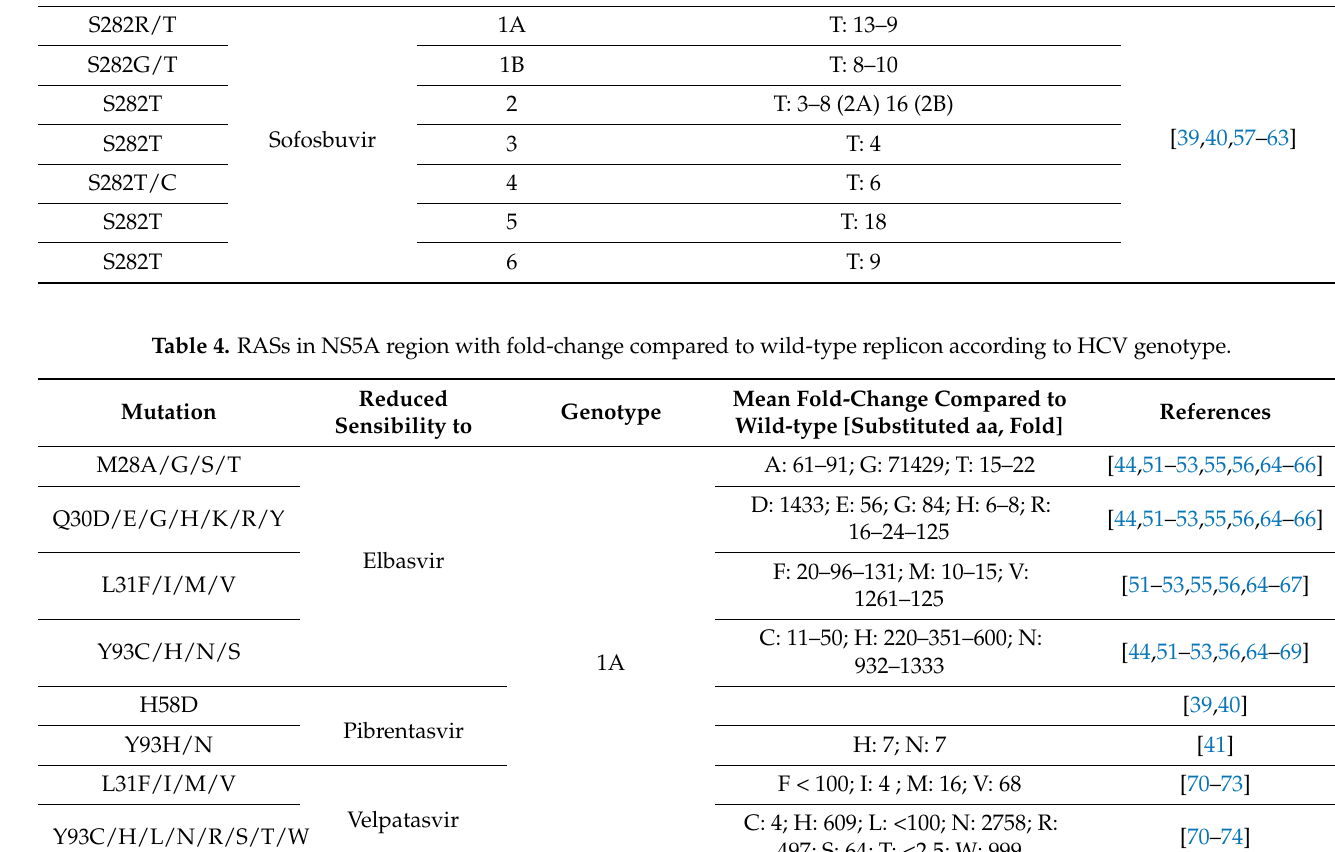
Table 3. RASs in NS5B region with fold-change compared to wild-type replicon according to HCV genotype. Mutation